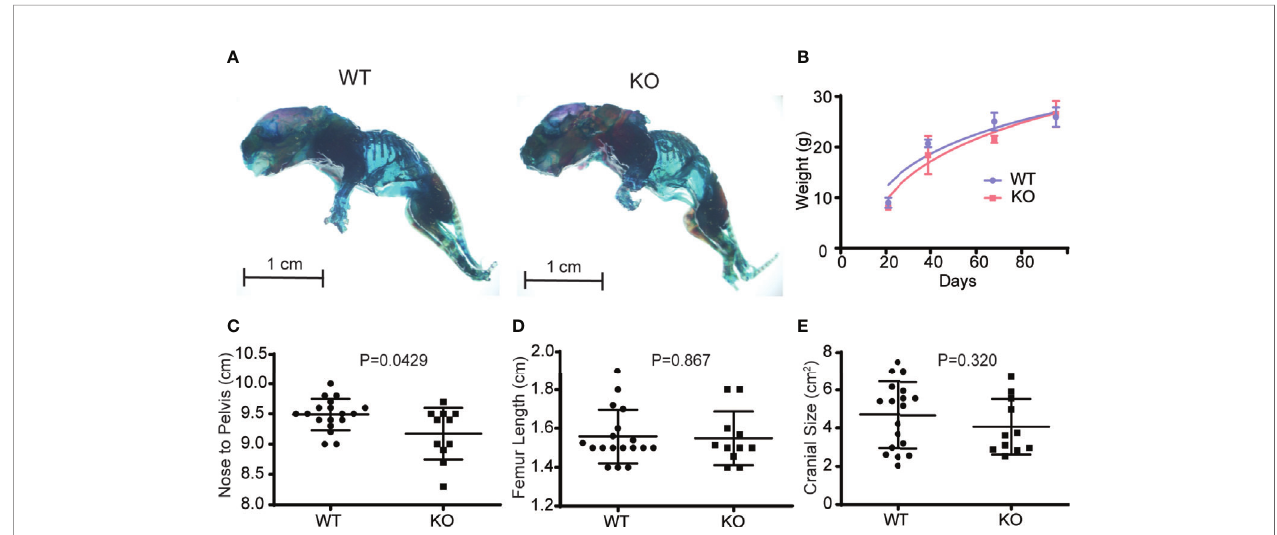
FIGURE 3 | Depletion of hematopoietic Wnts has a minimal effect on musculoskeletal development. (A) Whole-mount skeletal staining demonstrating similar gross skeletal structure in the wild type (WT) and knockout mice (KO). (B) Growth curves demonstrated no growth arrest or delay in the KO mice. (C) Nose to pelvis length, (D) femur length, (E) cranial size (cross sectional dimensions) were comparable for the KO and WT mice, with only nose to pelvis length demonstrating a marginal increase in the